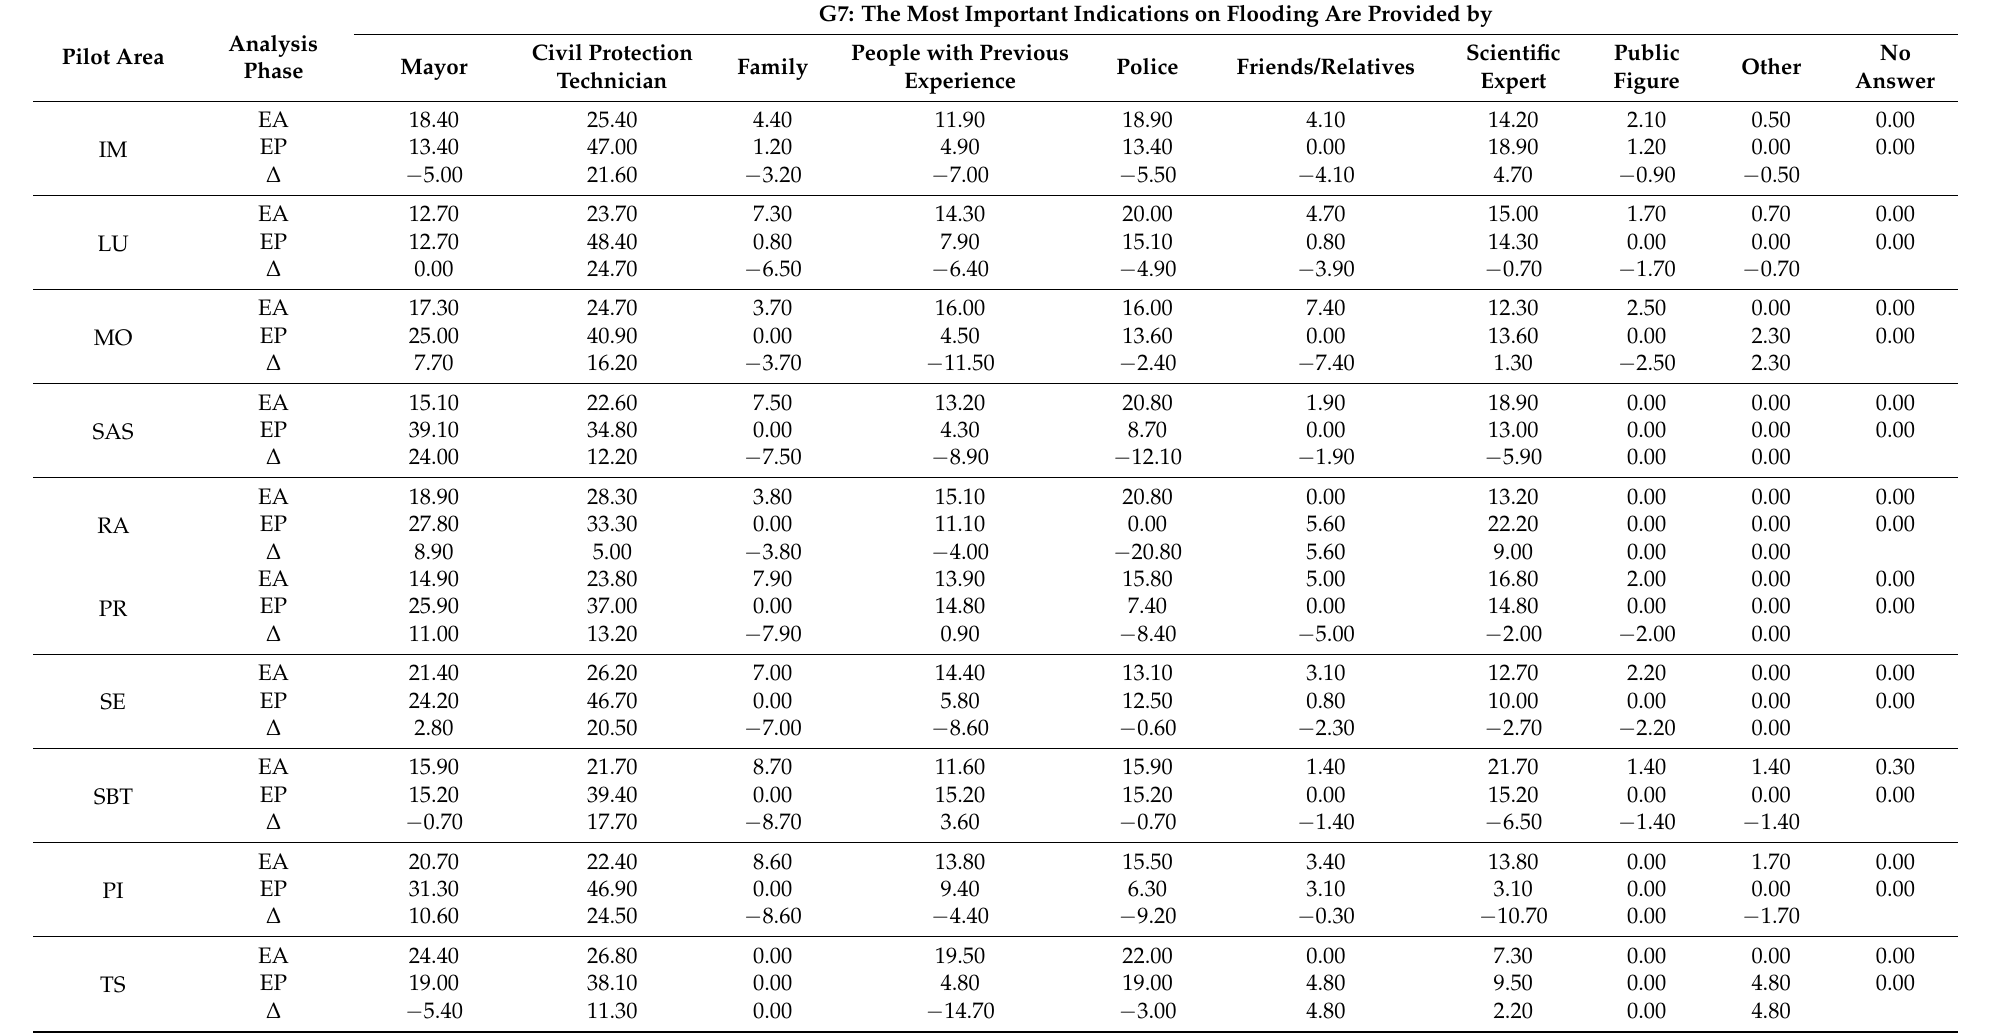
Table A8. Answers to the question G7 in percentages per each pilot area, in the ex-ante (EA) and in the ex-post (EP) phases, and their variation ( ∆ ).